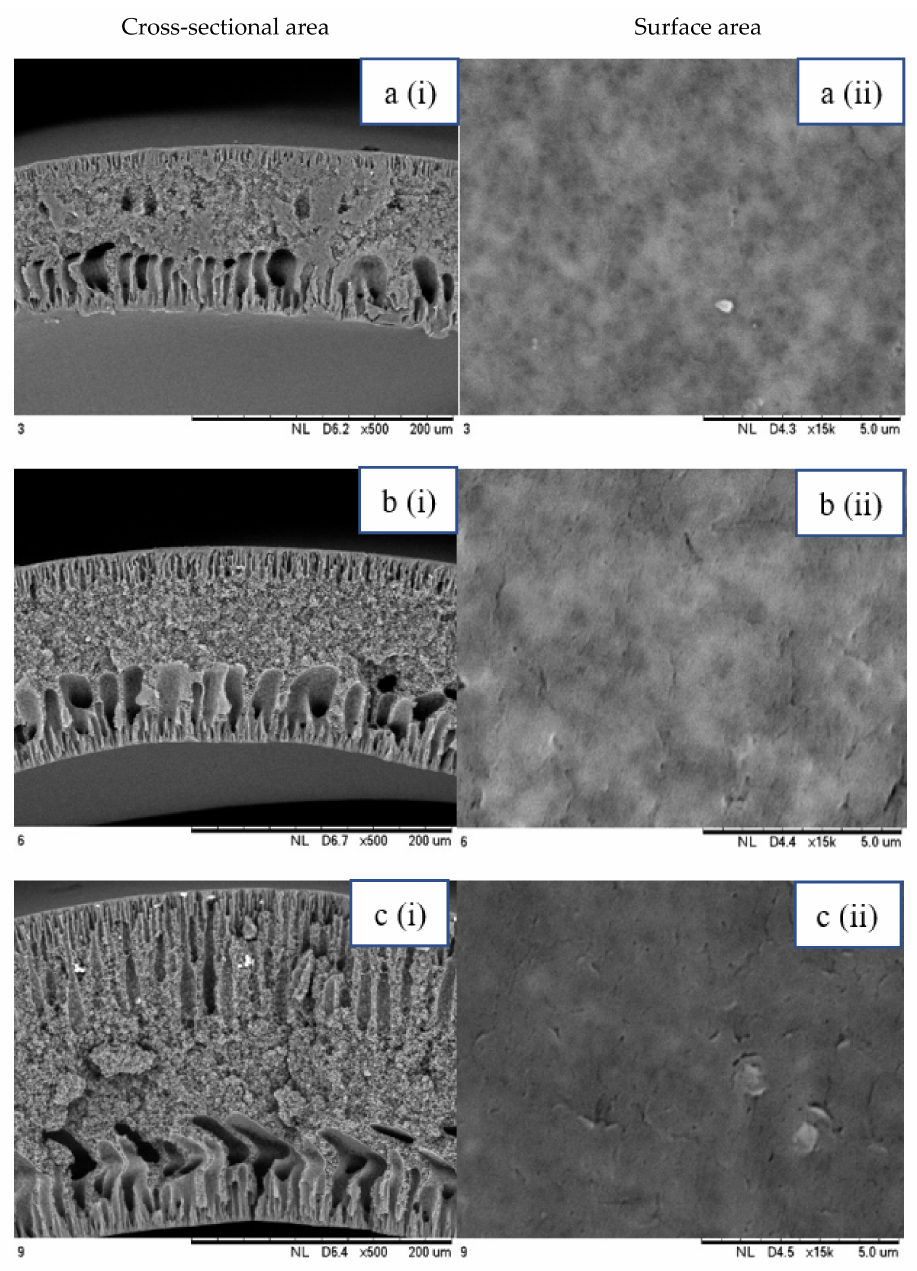
Figure 2. SEM image of 0.25 Cu 2 O/PVDF DLHF membrane with different outer dope flowrates: